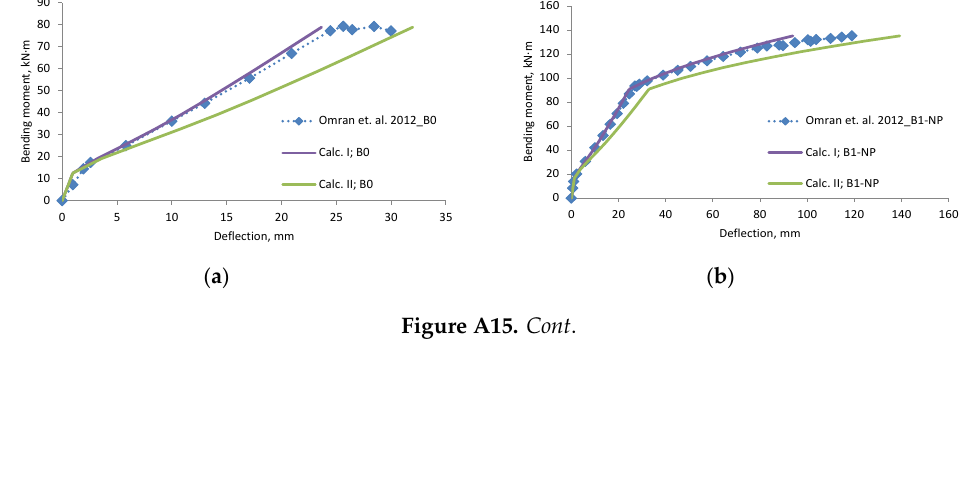
Figure A15. Cont